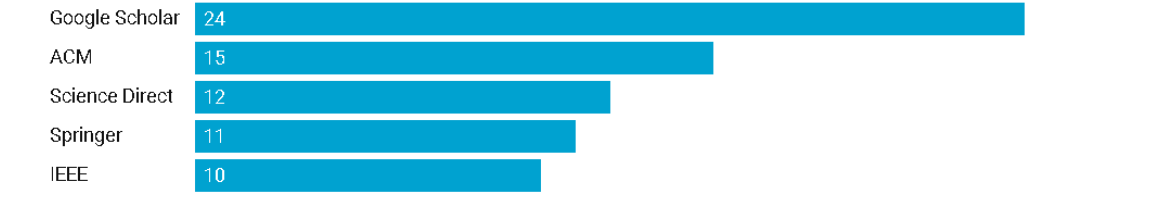
Figure 2. Number of research articles from database sources.